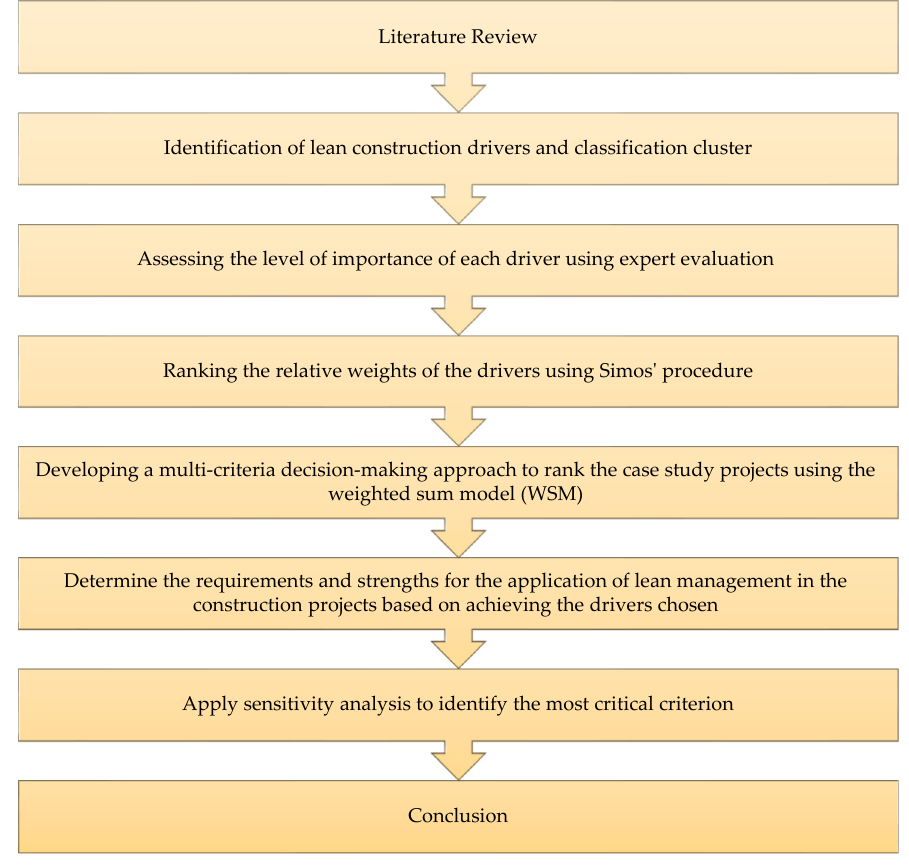
Figure 1. Research framework.